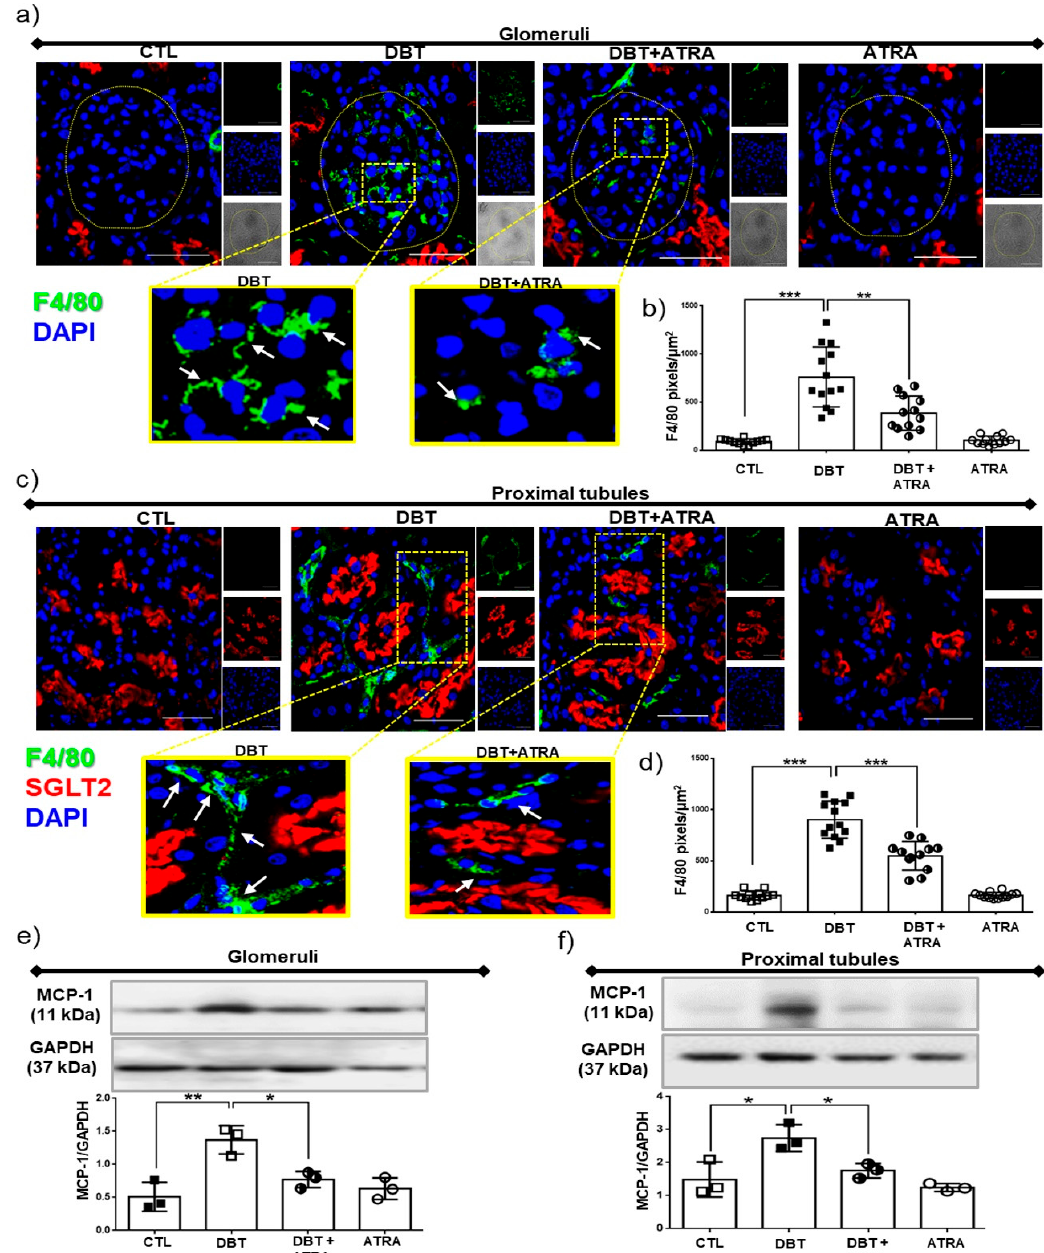
Figure 3. All-trans retinoic acid (ATRA) reduced the infiltration of F4 / 80 positive macrophages during initiation of diabetic nephropathy (DN). Confocal microscopy analysis for cellular localization of macrophages in renal sections. ( a ) Immunofluorescence images of F4 / 80 positive cells (green label) in glomeruli, ( b ) quantification of F4 / 80 positive per glomerular area (fluorescence intensity), ( c ) macrophage infiltration (F4 / 80 cells) into the interstitial space of proximal tubule (red label, sodium-glucose cotransporter 2, SGLT2, was used as a specific marker of proximal tubules), and ( d ) quantification of tubulointerstitial F4 / 80 infiltration. Nuclei were counterstained with 4 ′ ,6-diamidino-2-phenylindole (DAPI, blue label). Western blot analysis of monocyte chemoattractant protein 1 (MCP-1) in ( e ) isolated glomeruli and ( f ) isolated proximal tubules. In early stage of DN increased in renal macrophage infiltration and MCP-1 expression was elevated but was suppressed with ATRA treatment. Glyceraldehyde 3 phosphate dehydrogenase (GAPDH) was used as loading control. Data are representative of three independent experiments, and values are expressed in mean ± SD. * p < 0.05, ** p < 0.01, *** p < 0.001. The scale bar is equal to 50 µ m.